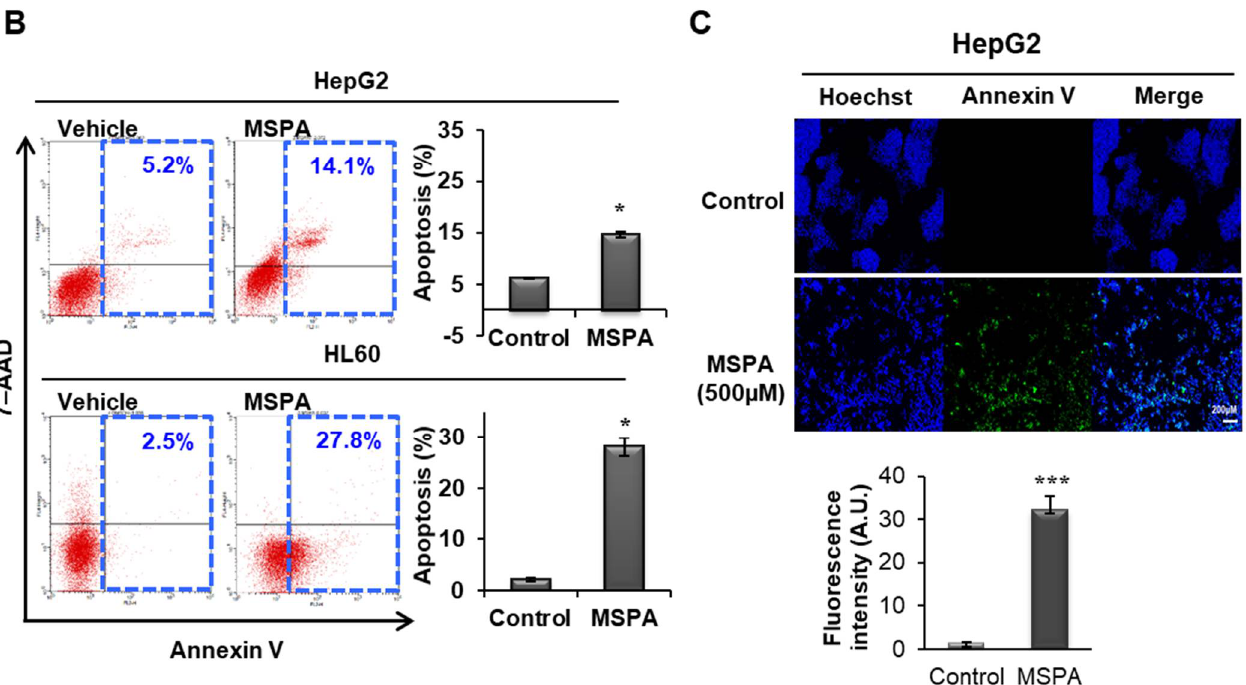
Figure 1. ( A ) The cytotoxic effects of macrosphelide A (MSPA) in cancer cell lines and non-cancer cell lines at 48 h, 72 h, and 96 h time points. The mock group represents vehicle-treated cell lines. Data represent the mean ± SD ( n = 3). * p < 0.05, ** p < 0.01 **** p < 0.0001 versus vehicle-treated group (mock). ( B ) Apoptosis was determined using annexin V/7-aminoactinomycin D (7-ADD) staining in HepG2 and HL60 cell lines. Combined annexin V and 7-AAD reactivity allowed cells to be classified into four groups: early apoptotic cells (annexin V (+) and 7-AAD ( − )), late apoptotic or dead cells (annexin V (+) and 7-AAD (+)), dead cells (annexin V ( − ) and 7-AAD (+)), and live cells (annexin V ( − ) and 7-AAD ( − )). Data represent the mean ± SD ( n = 3). * p < 0.05, versus vehicle-treated cells. ( C ) HepG2 cells were treated with 500 µ M of MSPA for 72 h and stained with annexin V Alexa Fluor 488 (green fluorescence). Cell nuclei are stained blue (Hoechst stain). Data represent the mean ± SD ( n = 3). *** p < 0.001 versus control (mock).